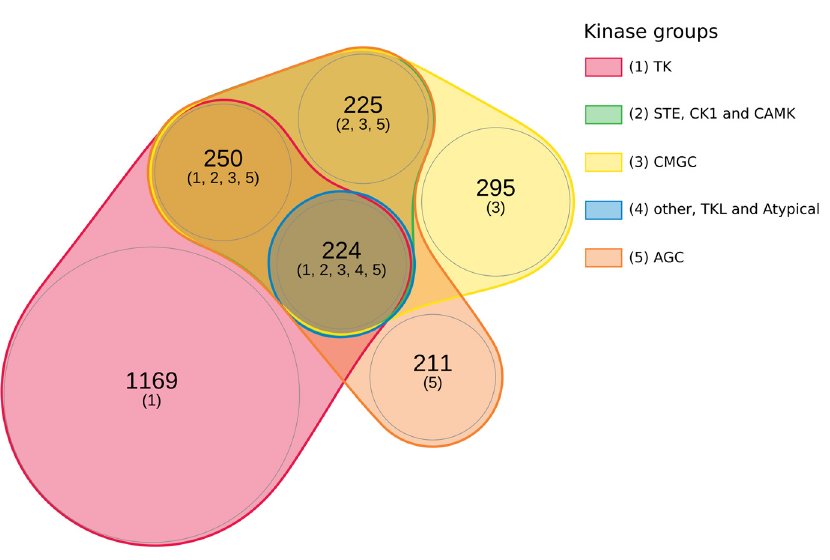
Figure 10. A filtered Euler diagram of the significant groups of proteins phosphorylated by five major kinase groups. The Euler diagram represents the overlapping sets of proteins phosphorylated by the most prominent kinase groups, i.e., those that target more than 2% of the total proteins. The STE, CK1, and CAMK groups, which phosphorylate exactly the same proteins, are grouped in a same category. The same goes for the groups of kinases Other, TKL, and Atypical. In the figure, each kinase group is identified by a number between brackets (from 1 for TK to 5 for AGC). The number of proteins corresponding to each region of the diagram is specified, followed by the identifiers of the kinase groups that phosphorylate them. The area of each region in the diagram is proportional to the number of elements include.